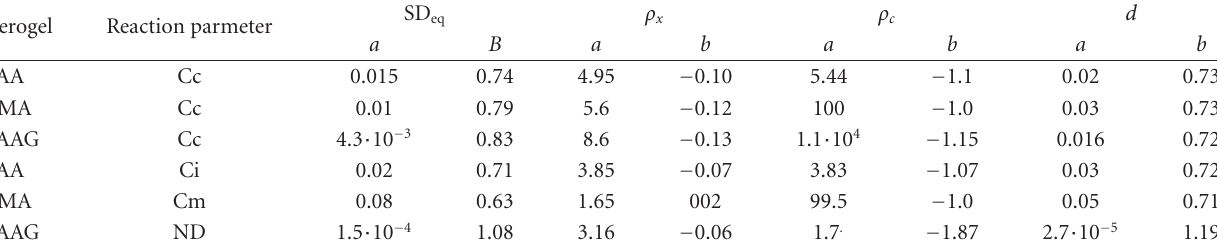
Table 8: The values of prefactor and scaling exponent of the MP and PSP on M c .